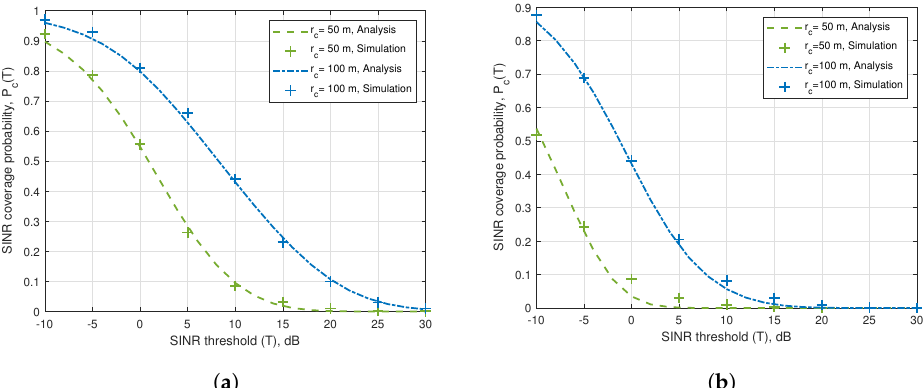
Figure 3. SINR coverage probability P c ( T ) vs. SINR threshold (T) for different blockage environment. ( a ) obstacle scaling factor ( ζ = 1) ( b ) obstacle scaling factor ( ζ =